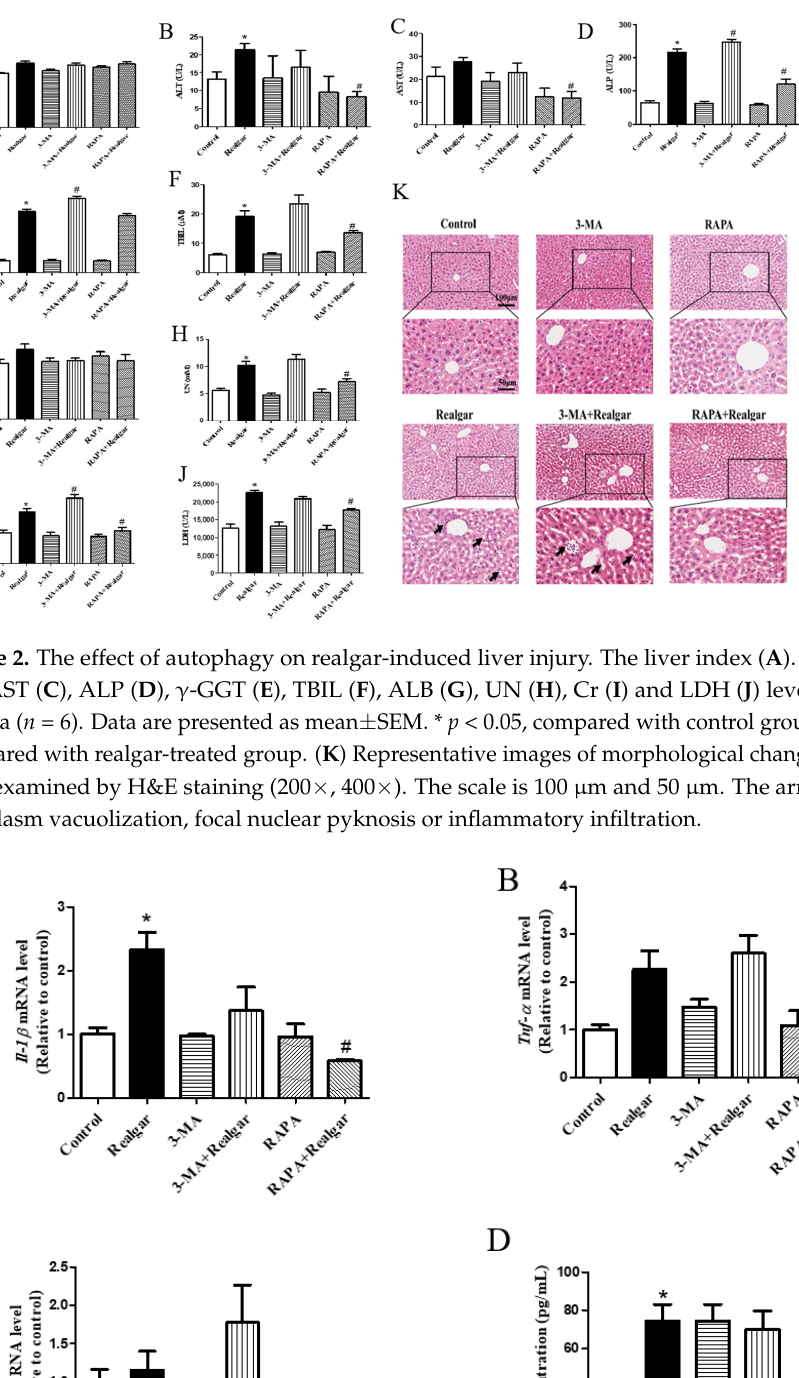
Figure 3. The effect of autophagy on pro-inflammatory cytokines expression and release. ( A – C ) The relative mRNA levels of Il- 1β , Tnf-a , Il-6 were evaluated by RT-qPCR and normalized the data to Gapdh ( n = 3). ( D ) The IL- 1β level in mouse plasma ( n = 6). Data are presented as mean ± SEM. * p < 0.05, compared with control group; # p < 0.05, compared with realgar-treated group. 3.4. Autophagy Retard Realgar Induced NLRP3 Inflammasome Activation in Mouse Livers The protein expressions of NLRP3, ASC, Caspase-1, IL- 1β, GSDMD, N -GSDMD and